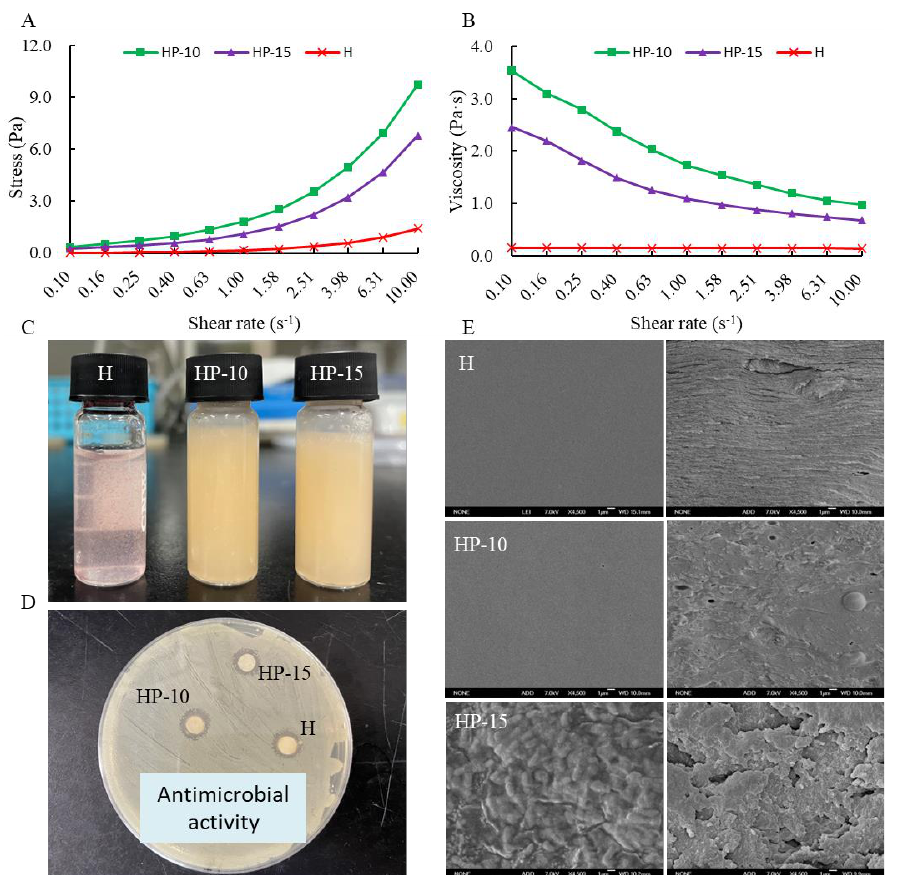
Figure 2. The characterization of coating solution and film. ( A ) The relationship between stress and shear rate, ( B ) the relationship between viscosity and shear rate, ( C ) the different coating solutions, ( D ) the antimicrobial activity of coating solutions, and ( E ) the micrograph (SEM) of the surface and the cross-section of films (H: 2% sodium alginate + antibacterial agents; HP-10: 2% sodium alginate + antibacterial agents + 1:10 protein solution; HP-15: 2% sodium alginate + antibacterial agents + 1:15 protein solution).